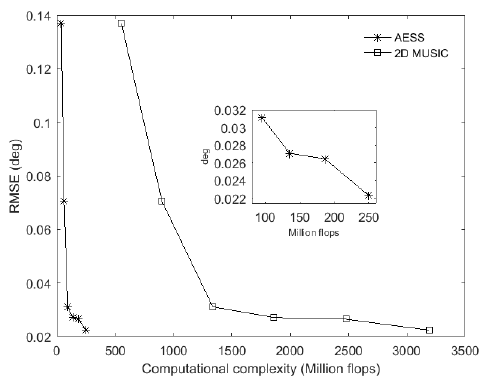
Figure 5. RMSE versus computational complexity .